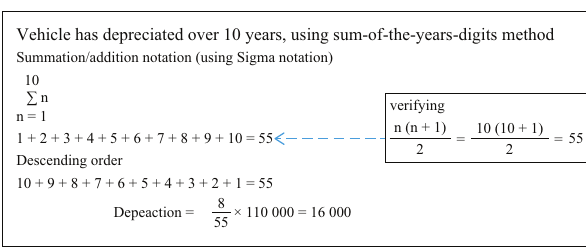
FIGURE 19: Sum-of-the-years-digits